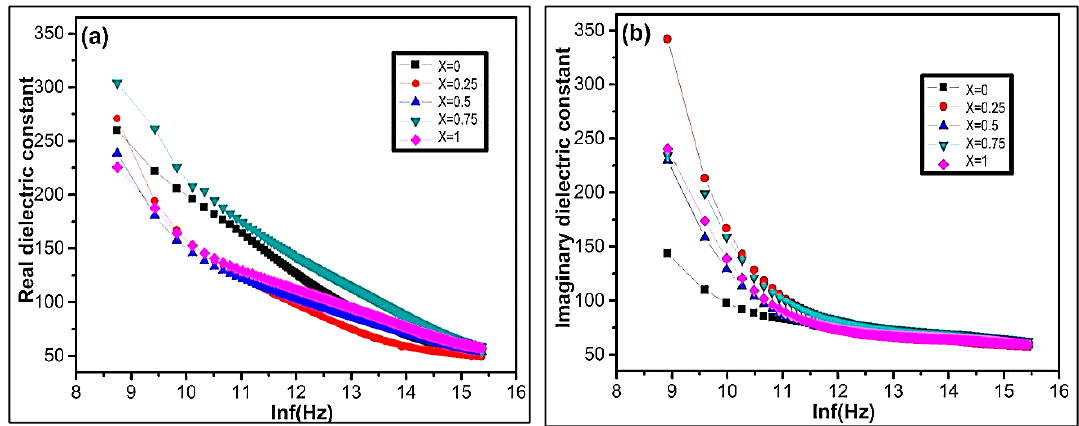
Figure 6. The variation of ( a ) real dielectric constant ε′ and ( b ) imaginary dielectric constant ε″ as a function of lnf(Hz) of Ni 1-x Zn x Fe 2 O 4 .